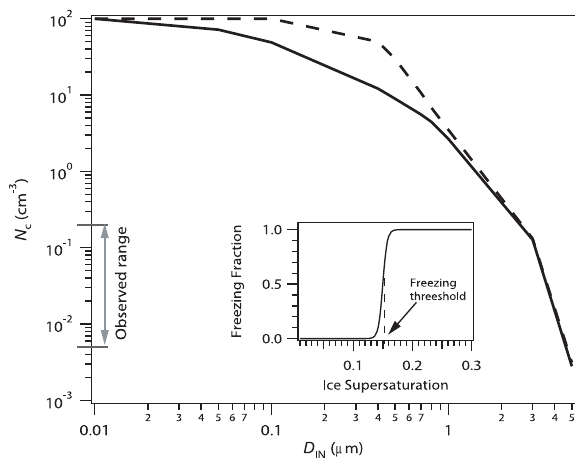
Fig. 2. Simulations of ice crystal concentration by pure heteroge- neous freezing. N c is presented as a function of the initial size of the ice nuclei. Conditions (Lawson et al., 2008) used were T = 185K, p = 100hPa, and vapor-to-ice deposition coefficient, α d , of 0.07 (dashed line), and 1.0 (solid line). The IN population was assumed to be monodisperse with total number concentration of 100cm − 3 (Lawson et al., 2008). Freezing of solid ammonium sulfate was assumed to occur in a “burst” around the heterogeneous freezing threshold described by sigmoidal freezing spectrum with inflection point S het = 15% (Abbatt et al., 2006), where 99% of the aerosol freeze within a 2% supersaturation interval about S het (inset plot).